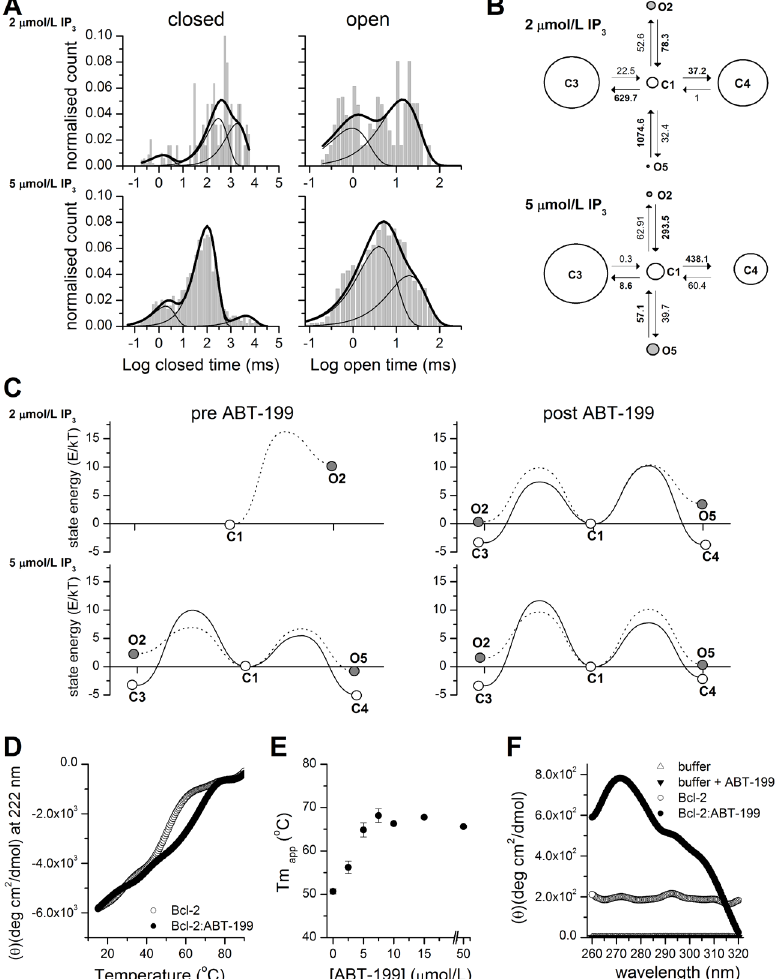
R kinetic states. Figure 2. ABT-199 significantly affects the stability of Bcl-2 and the opening energy of Bcl-2 bound IP 3 (A). Representative distributions of closed (left) and open (right) dwell times in the single-channel traces of IP R activity stimulated 3 by 2 μmol/L or 5 μmol/L IP as indicated after application of 1 μmol/L ABT-199 ( n = 4 for both concentrations). The histogram shows 3 the distribution of dwell times. The thick continuous line represents the cumulative best fit corresponding to the kinetic model used and broken lines represent individual components of the fit. (B). Kinetic models providing the best fit to the IP R inhibited by Bcl-2 3 activity stimulated by 2 μmol/L or 5 μmol/L IP and following the application of ABT-199. Letters C and O denote closed and open 3 kinetic states. The area of each circle is proportional to the log of total time spent in the corresponding state. Kinetic rates (s –1 ) are indicated as numbers associated with the corresponding arrows indicating interstate transitions. (C). Energy landscape plots summarizing the relative energies of closed and open states calculated from the corresponding kinetic models at indicated [IP ] 3 before (left) or after (right) ABT-199 application. Solid lines connecting C1 to open circles represent energy barriers for the transition between closed states and dotted lines represent transitions from C1 to open states. (D). Thermal denaturation curves (15°–90°C) obtained by monitoring ellipticity at 222 nm, by far - UV CD, while heating (at 1°C/min −1 ) the Bcl-2 protein samples (15 μmol/L) in the presence or absence of 15 µmol/L ABT-199 (as indicated). A representative experiment is shown, following smoothing (Origin; FFT filter 15; n = 3). (E). The Tm app of Bcl-2 protein in the absence or presence of the indicated ABT-199 concentration was determined from experiments performed under conditions described in panel D. (F). Near-UV CD spectra recorded for Bcl-2 (15–20 µmol/L) in the absence (empty circles) or presence (filled circles) of 50 µmol/L ABT-199. Control-spectra were recorded for buffer alone (empty triangles) or buffer plus ABT-199 (filled triangles) under identical conditions. A representative experiment, following smoothing, is shown ( n =